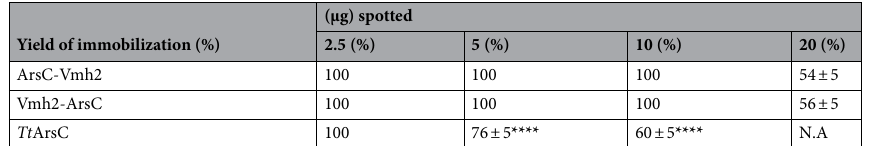
Yield of immobilization